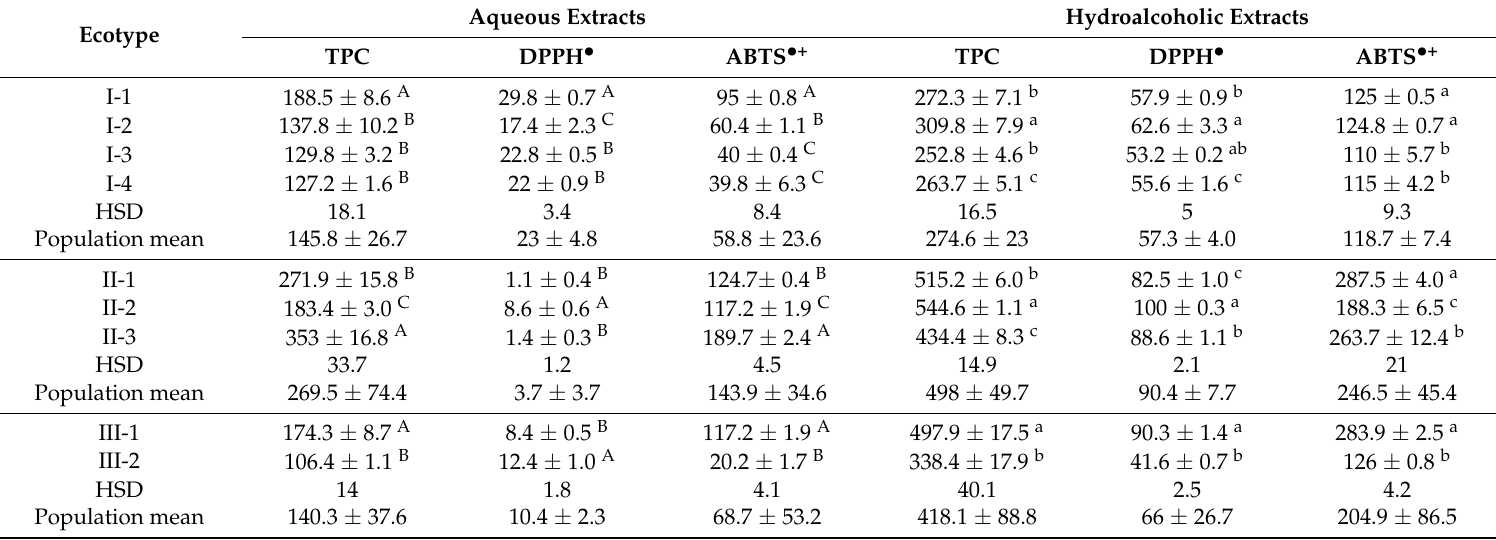
Table 1. Inter- and intra-population phenols variation and free radical-scavenging capacities of wild Piquin chili in aqueous extracts and hydroalcoholic extracts.